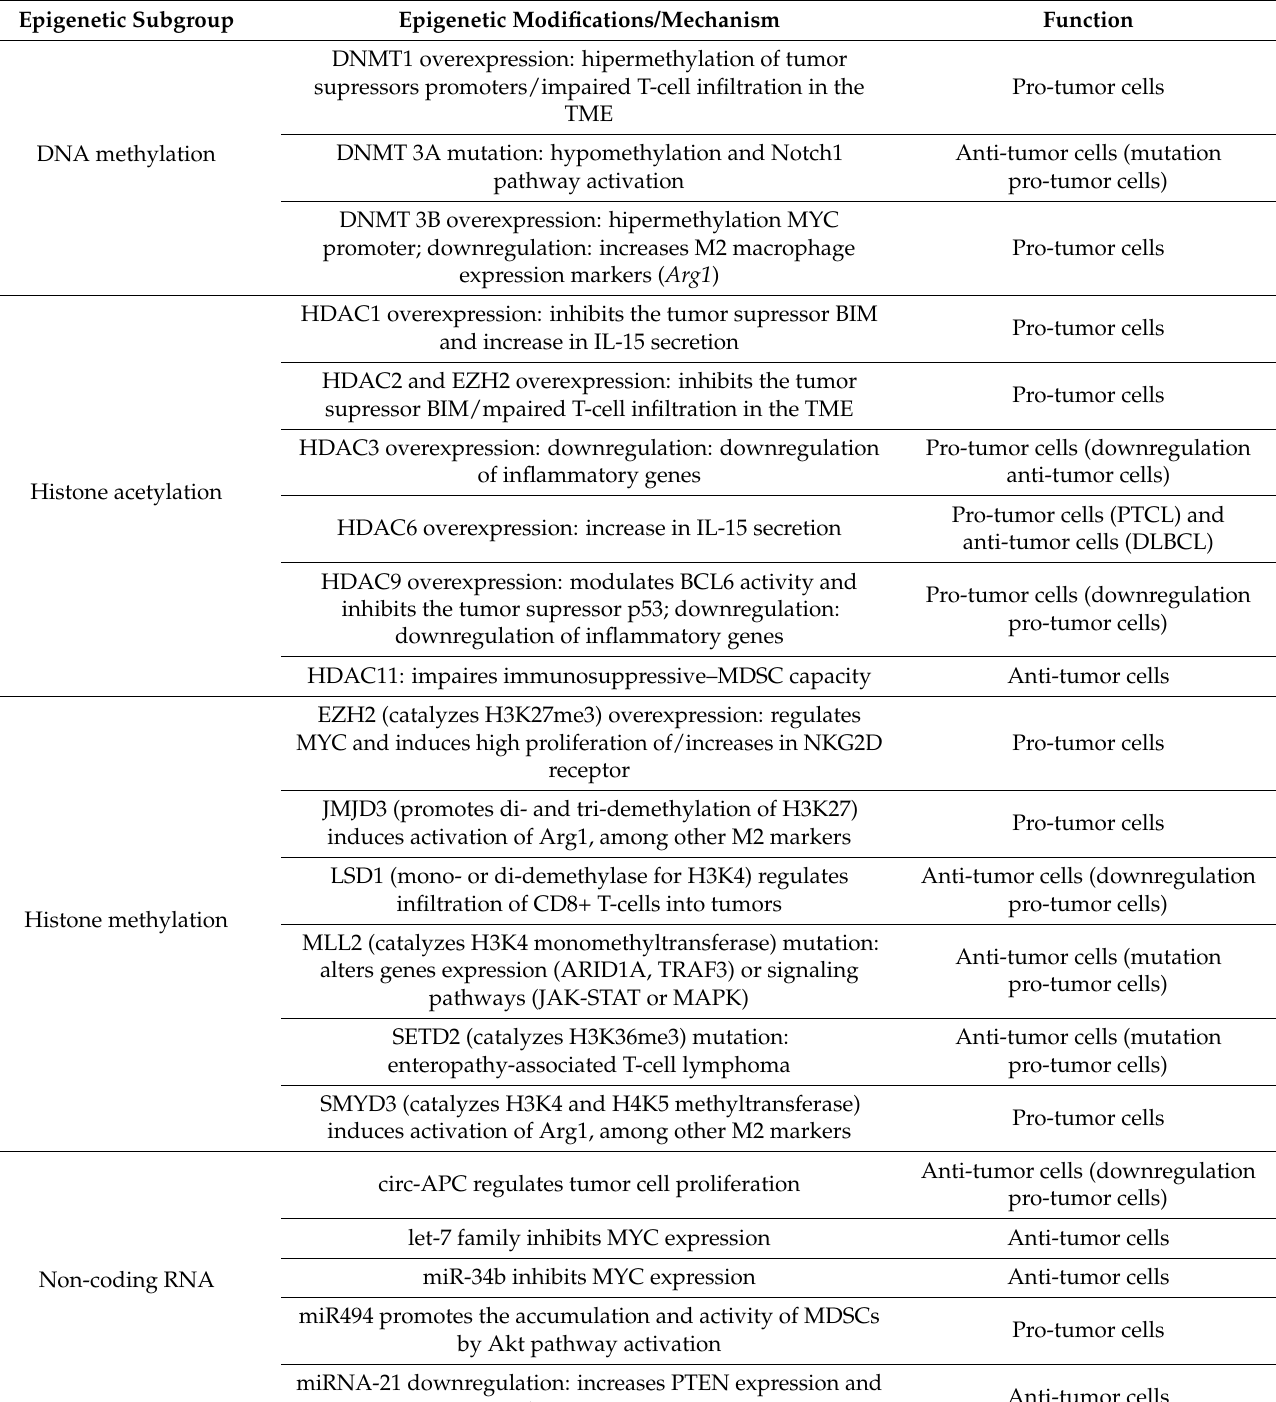
Table 2. Epigenetic modifications involved in lymphoma